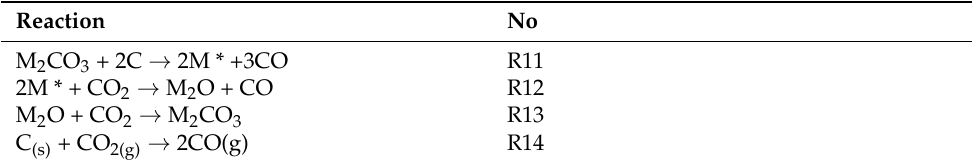
Table 4. Mechanism of the alkali carbonate-assisted carbon CO 2